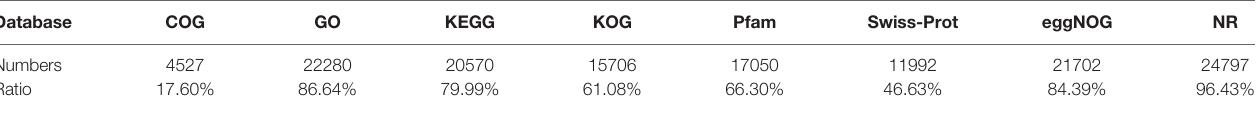
TABLE 3 | Statistics of database annotation